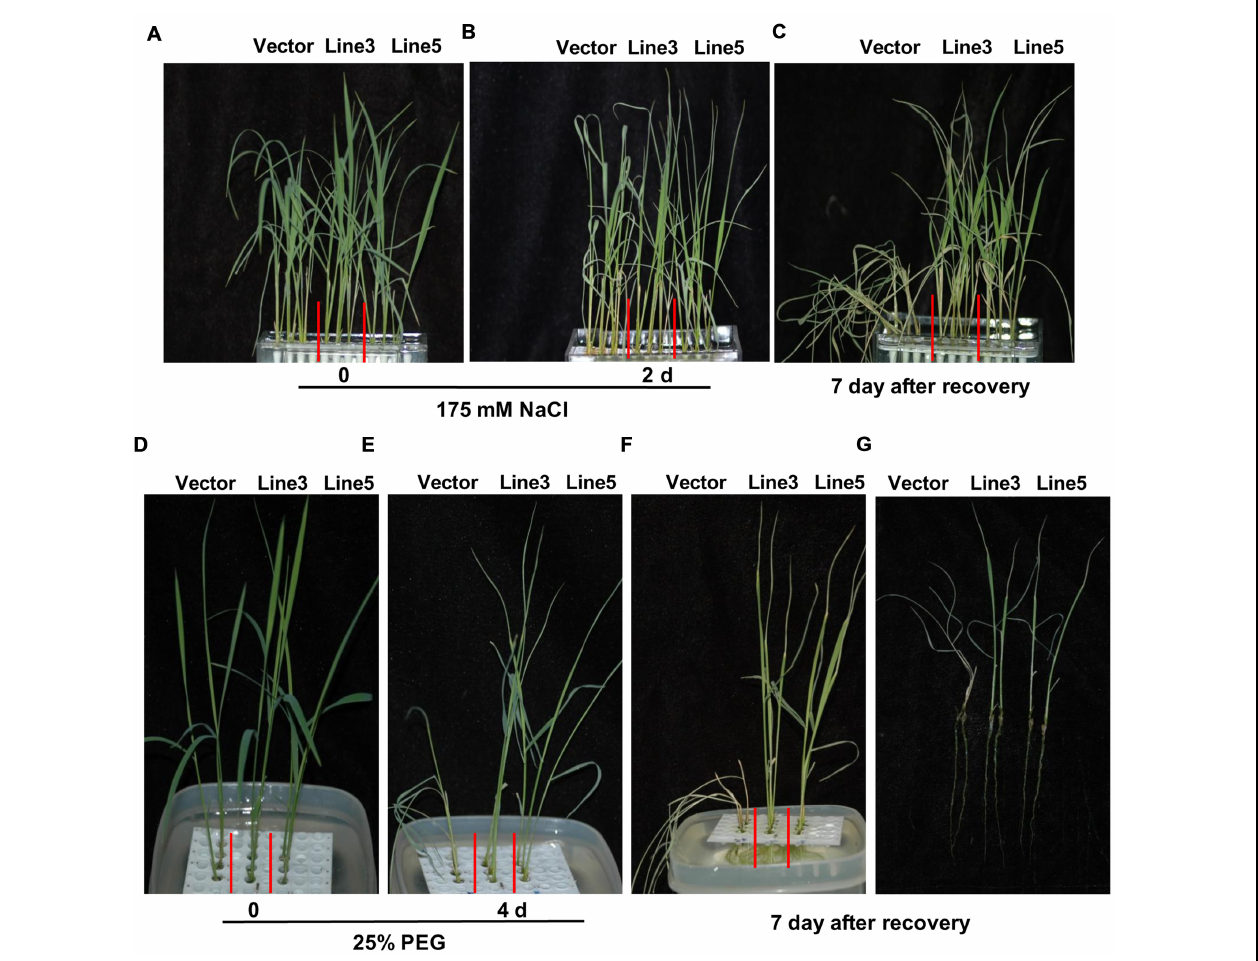
FIGURE 5 | Improved NaCl and PEG tolerance in transgenic rice. (A) Before NaCl treatment. (B) NaCl treatment for 2 days. (C) Recovery for 7 days after 2 days NaCl treatment. (D) Before PEG treatment. (E) PEG treatment for 4 days. (F,G) Recovery for 7 days after 4 days PEG treatment. NaCl and PEG stress was imposed on 4-week-old T3 transgenic seedlings under water culture conditions in greenhouse. Experiments were repeated three times and at least 30 plants for each individual lines were used in each repeated experiment and one representative picture was